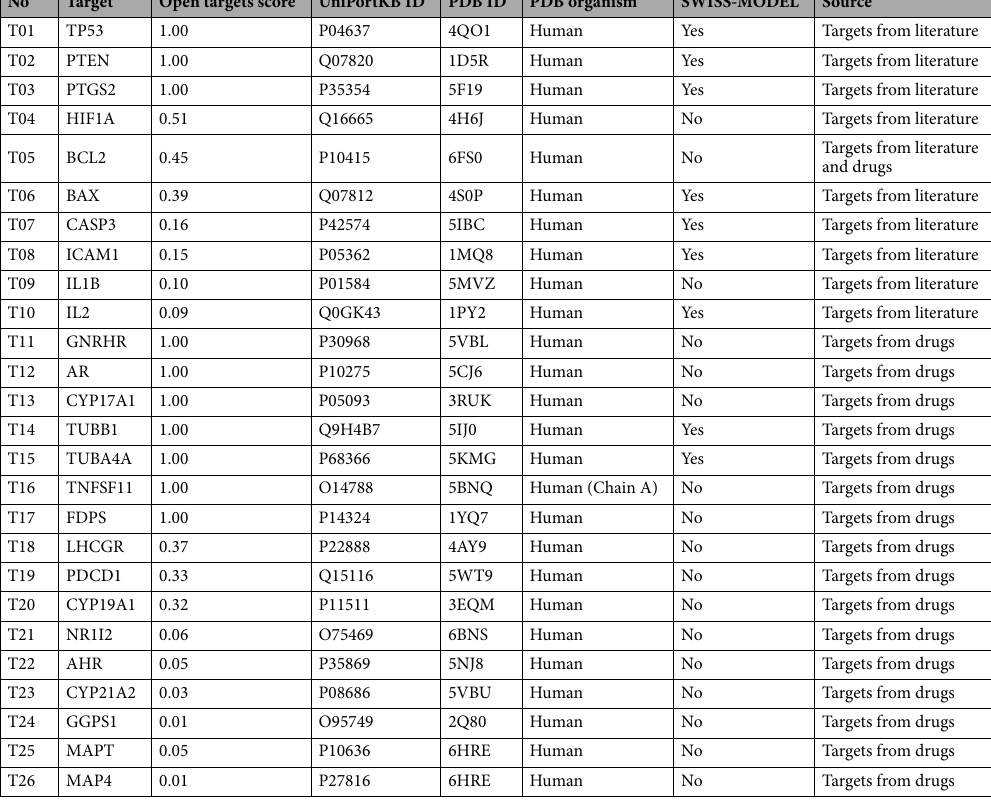
Table 1. Characteristics of 26 identified targets for prostate cancer. AHR aryl hydrocarbon receptor, AR androgen receptor, BAX B-cell lymphoma-2 associated X, BCL2 B-cell lymphoma-2, CASP3 Caspase